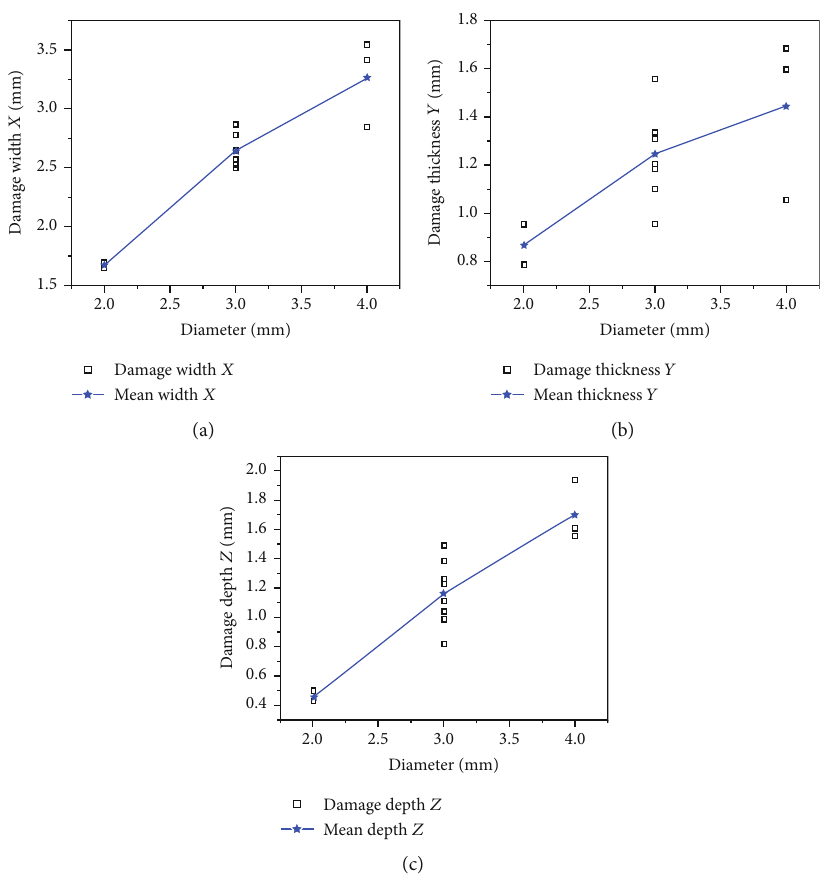
Figure 9: The relationship curve between damage size and steel ball diameter: (a) damage width X with steel ball diameter; (b) damage thickness Y with steel ball diameter; (c) damage depth Z with steel ball diameter.